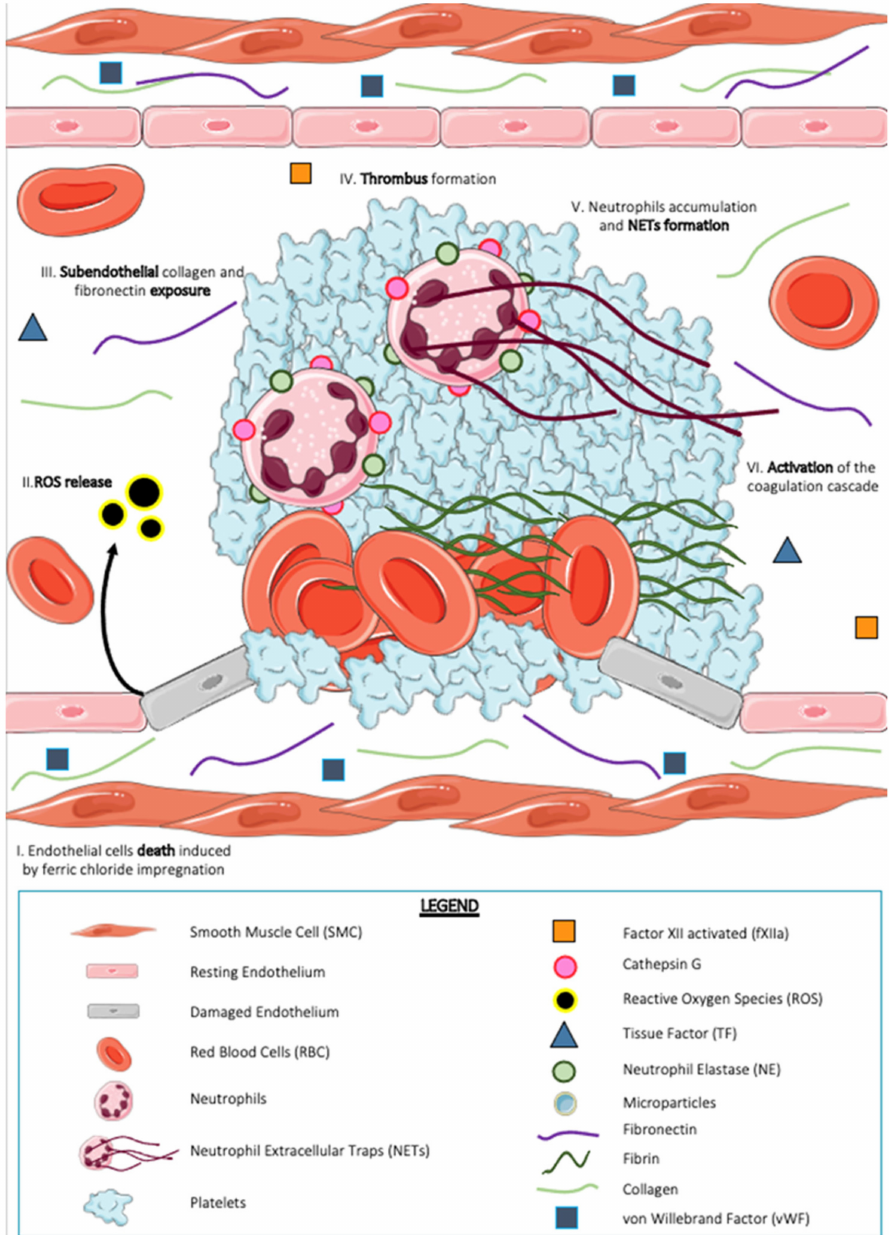
Figure 1. Thrombus formation after ferric chloride (FeCl 3) exposure. In the FeCl 3 exposure model, the blood vessel wall is exposed to iron chloride for a few minutes, usually less than ten minutes. This exposure causes cell death in the vascular endothelium (I) and generation of reactive oxygen species (ROS) (II). All the blood component and cells are exposed to the subendothelial matrix (III) (collagen, fibronectin, von Willebrand factor). This leads to platelet activation via an GPVI-collagen interaction and thus to their aggregation; some red blood cells could be trapped in the thrombus (IV). Neutrophils accumulate in the growing thrombus and form neutrophil extracellular traps (NETs) (V). The activation of the coagulation cascade is tissue factor (TF)-dependent in this model (VI) and leads to fibrin